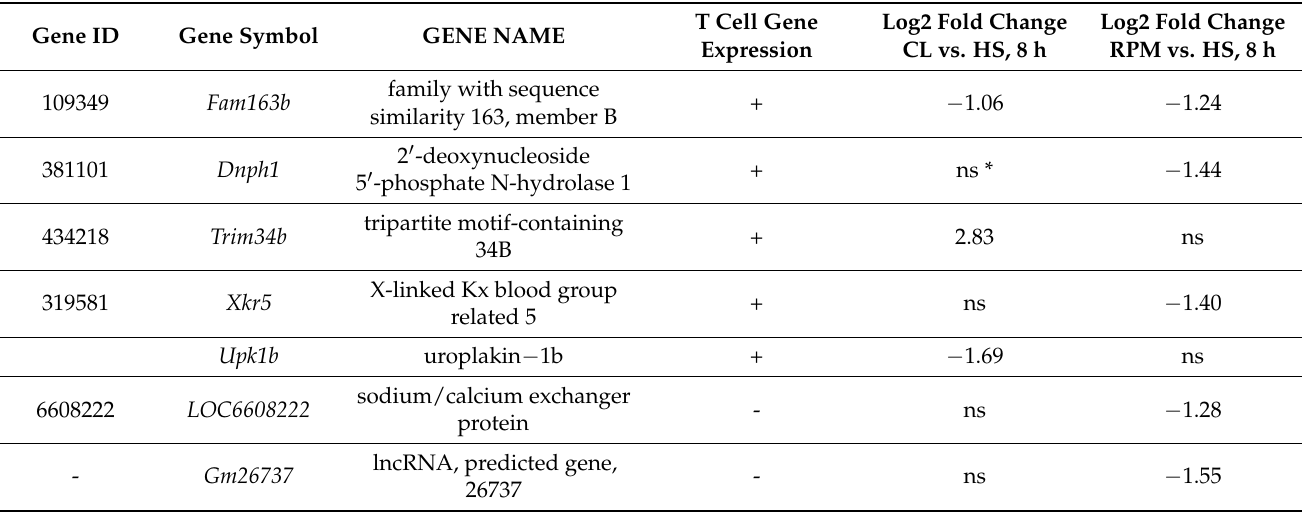
Table A2. The significantly differentially expressed genes in CL or RPM or both platforms at 8 h of simulated microgravity versus hydrodynamic stress treatment.